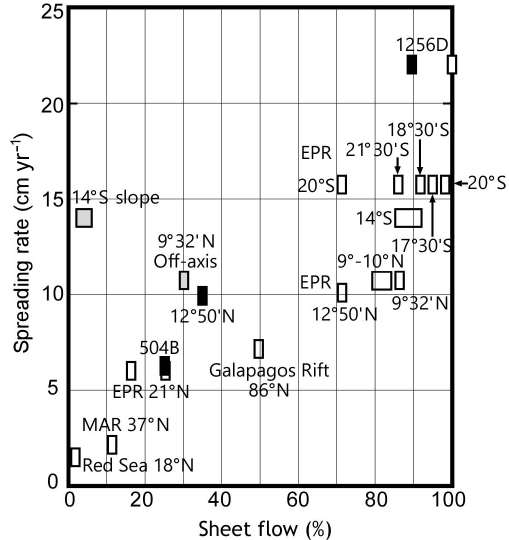
Figure 8. Spreading rate dependency of flow morphology of the mid-ocean ridges. Open, gray, and black symbols represent on-axis, ridge slope, and all data from on-axis to off-axis. Note that the spreading rate dependency of flow morphology stands only for on- axis flows. Even if the spreading rate exceeds 10cmyr − 1 , steep ridge slopes are overwhelmingly covered with elongate pillows. This is because flow morphology of basalt lava extruded at a low rate is mainly determined by the basement slopes and changes from lobate lobes ( ∼ 0 ◦ ) through elongate, flattened pahoehoe-like lobes ( < 7 ◦ ) to elongate pillows ( > 10 ◦ ; Umino et al., 2000, 2002). The data sources are Ayadi et al. (1998), Bonatti and Harrison (1988), Meyer and White (2007), Tominaga et al. (2009), and Susumu Umino, unpublished data,